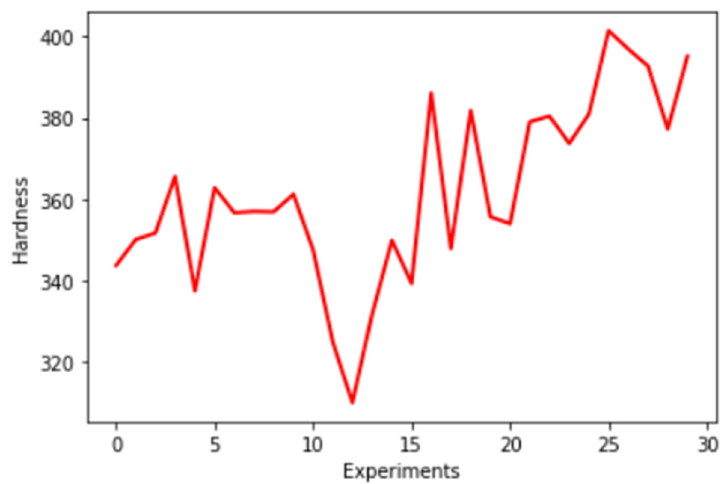
Figure 8. Actual hardness value against the number of experiments.